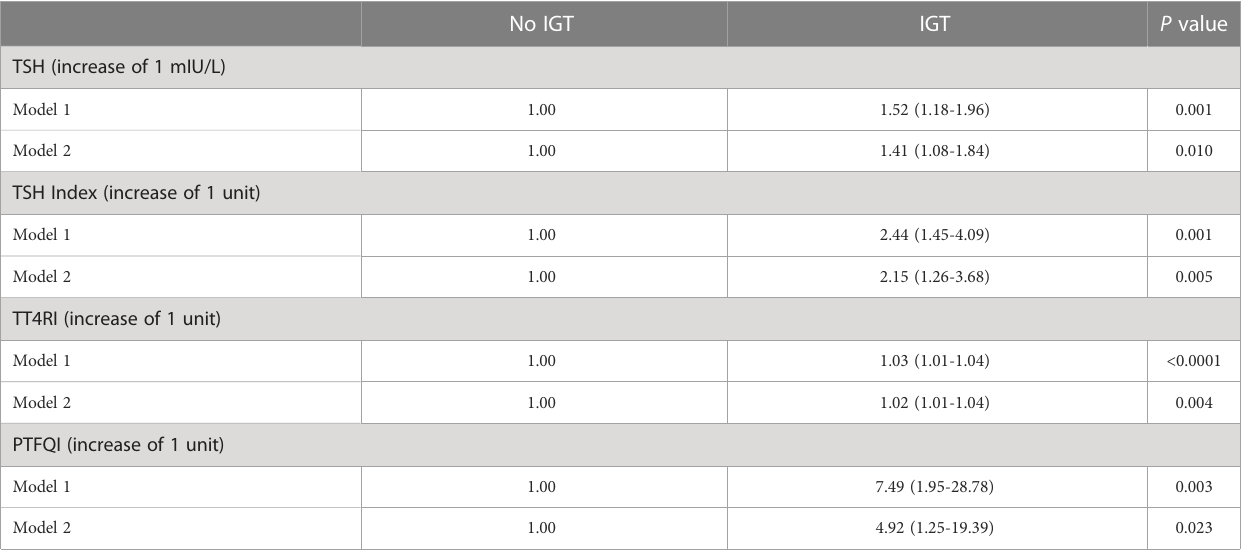
Model 1: P value adjusted for centers, age and prepubertal stage. Model 2: P value adjusted for centers, age, prepubertal stage, family history of type 2 diabetes, HOMA-IR, TG/HDL ratio, systolic BP, obesity, IFG and high HbA1c. TSH, thyroid stimulating hormone; TT4RI, Thyrotroph T4 Resistance Index; TFQI, Thyroid Feedback Quantile-based Index; PTFQI Parametric Thyroid Feedback Quantile-based Index;